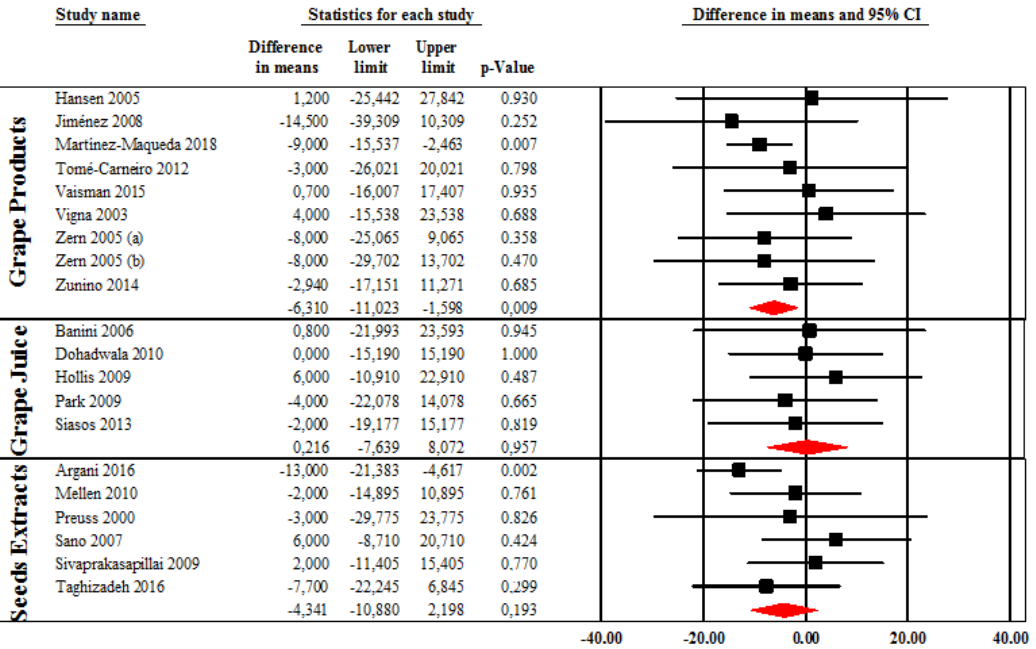
Figure 2. Changes in LDL-C levels in subjects taking whole grape products, grape juice, and grape seeds